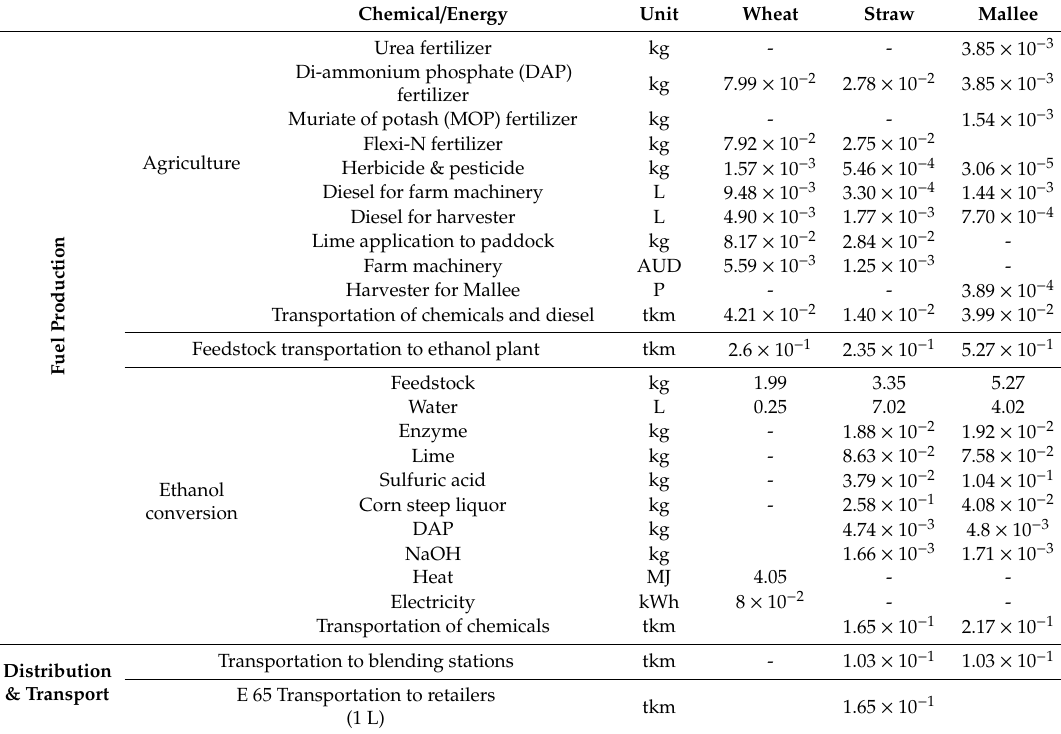
Table 7. Summary of inventory for 1 L ethanol production from wheat, straw and Mallee after allocation